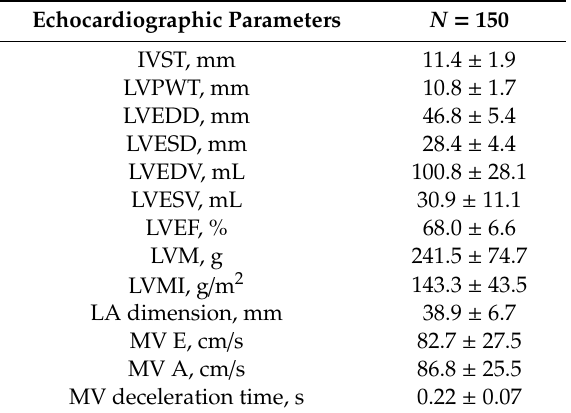
Table 2. Echocardiographic parameters of the study